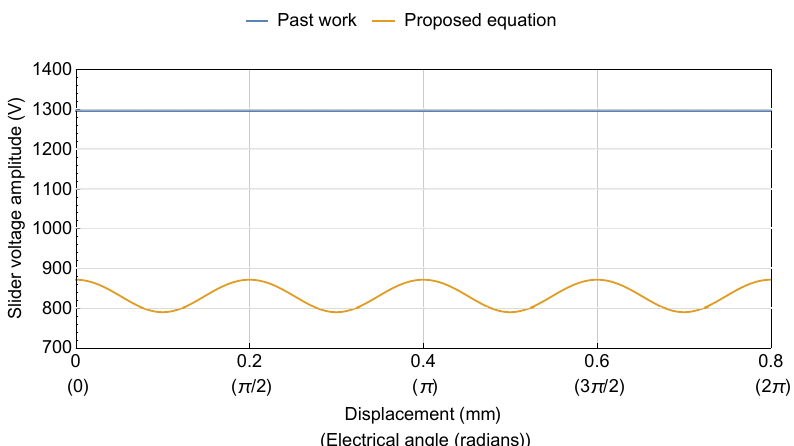
Figure 3. Comparison of the voltage amplitude output, as a function of displacement, between the newly proposed equation and the one reported in